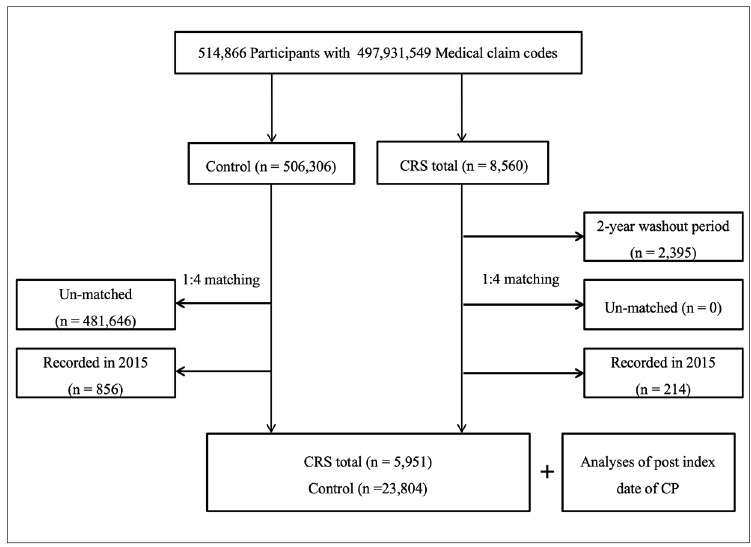
Figure 1. Schematic illustration of the participant selection process used in the present study. Out of 514,866 participants, 5951 chronic rhinosinusitis patients were matched with 23,804 control participants for age, sex, income, region of residence, and pre-index date chronic periodontitis for 2 years.